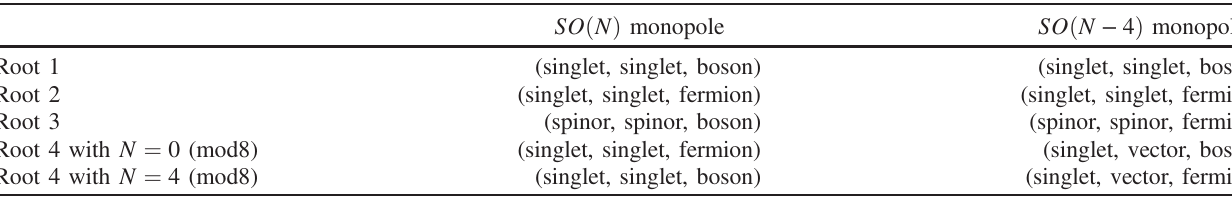
TABLE I. Properties of the SO ð N Þ and SO ð N − 4 Þ monopoles of the root states for even N . The first three roots apply to all even N , and root 4 only applies to the case with N an integral multiple of 4. The SO ð N Þ monopole breaks the I ð N Þ symmetry to ½ SO ð 2 Þ × SO ð N − 2 Þ × SO ð N − 4 Þ(cid:2) =Z 2 , and it always has no charge under the SO ð 2 Þ . Its three corresponding entries represent its representation under the SO ð N − 2 Þ , its representation under the SO ð N − 4 Þ , and its statistics, respectively. The SO ð N − 4 Þ monopole breaks the I ð N Þ symmetry to ½ SO ð N Þ × SO ð N − 6 Þ × SO ð 2 Þ(cid:2) =Z 2 , and it always has no charge under the SO ð 2 Þ . Its three corresponding entries represent its representation under the SO ð N Þ , its representation under the SO ð N − 6 Þ , and its statistics, respectively. For the case with N ¼ 6 , the second entry does not exist for its SO ð N − 4 Þ monopole. Note that these properties are determined up to attaching pure gauge